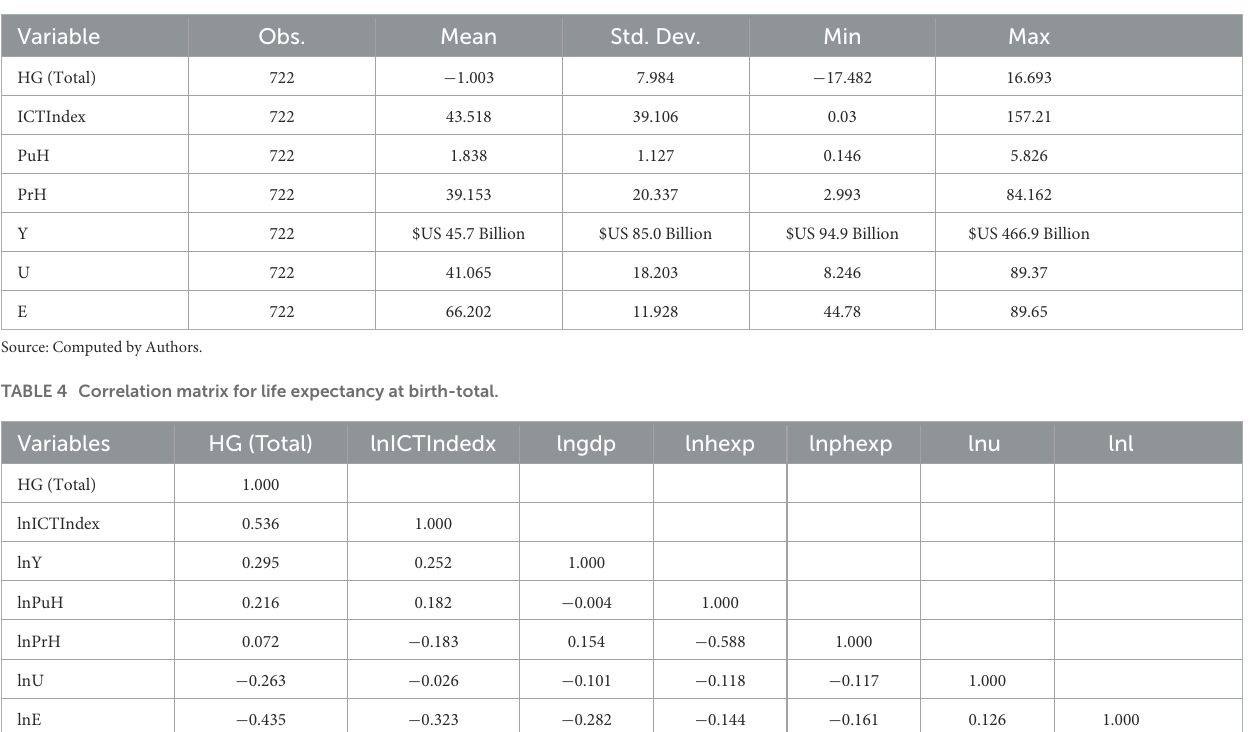
TABLE 3 Summary of descriptive statistics of variables.